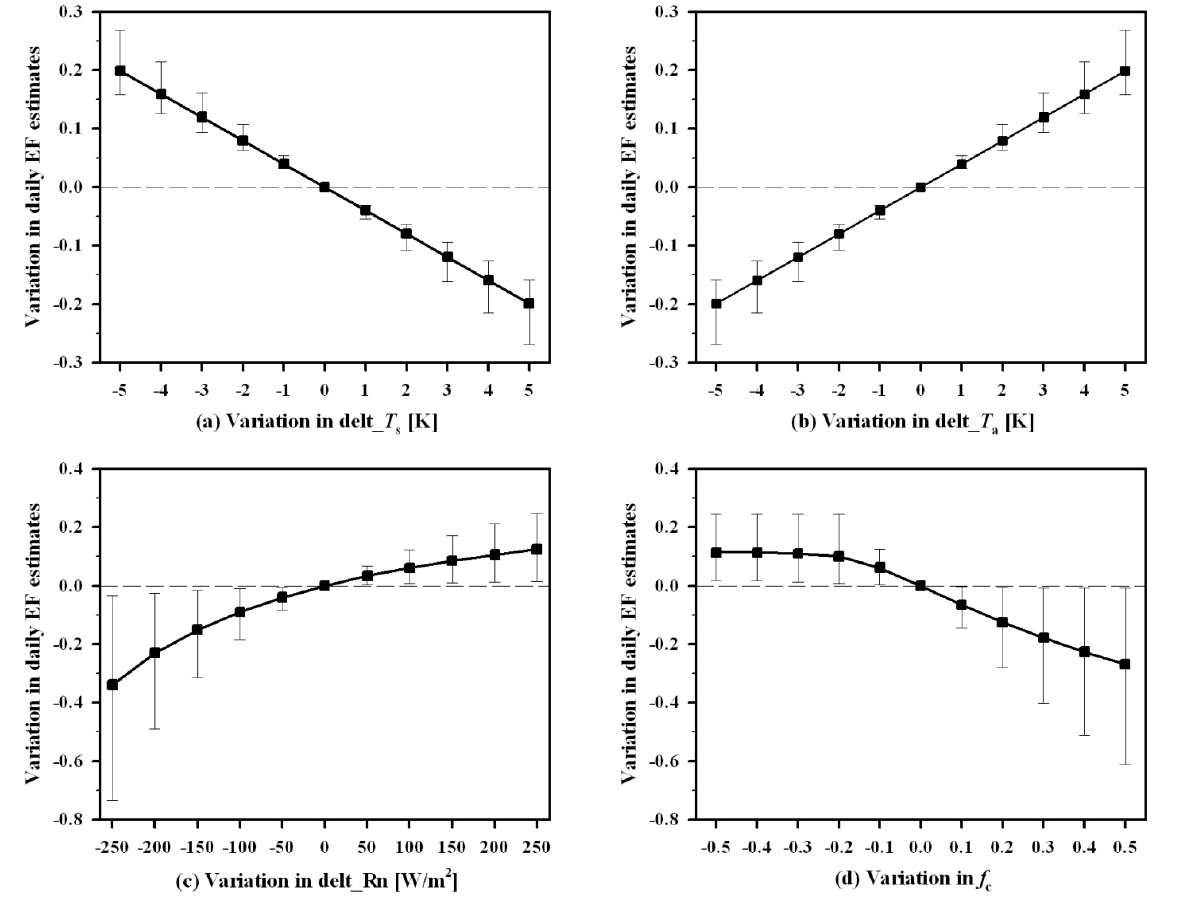
Figure 14. Variations in daily EF estimates caused by the variations in input variables daily EF estimates, whereas the error bars represent the range of